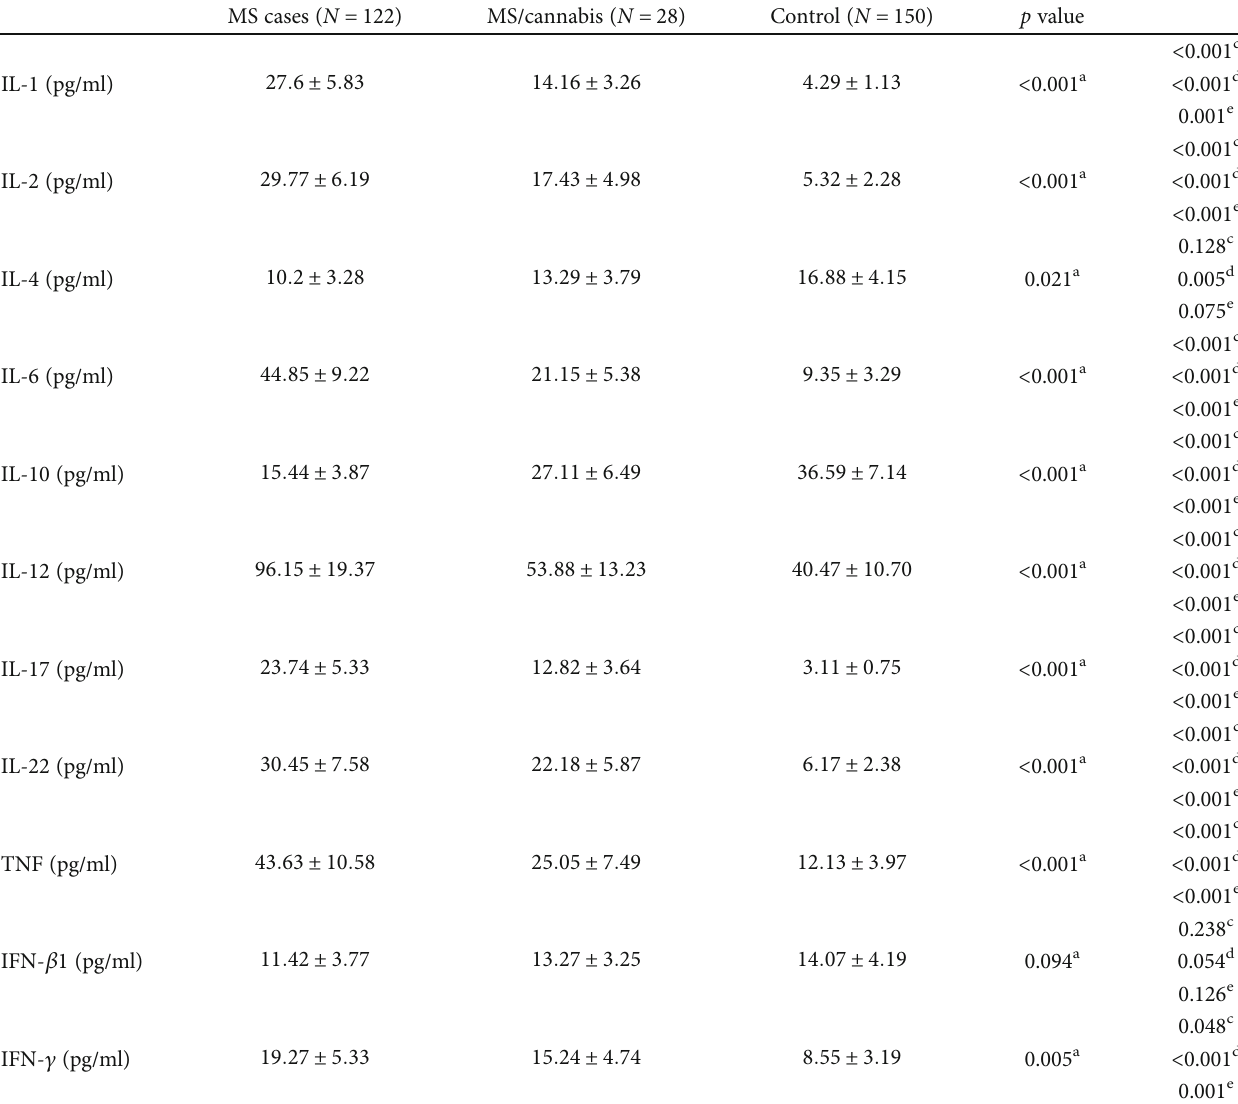
Table 3: Analysis of serum cytokines in the study